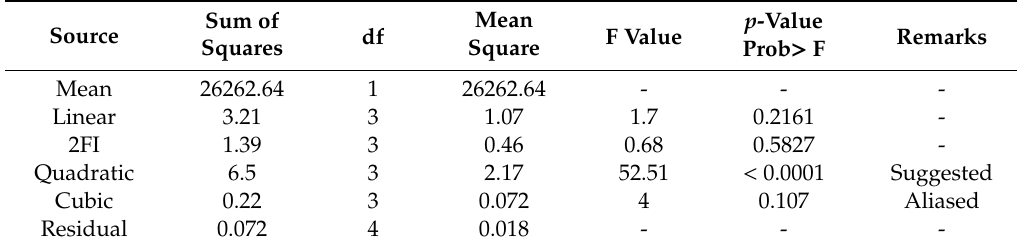
Table 4. Sequential model sum of squares.